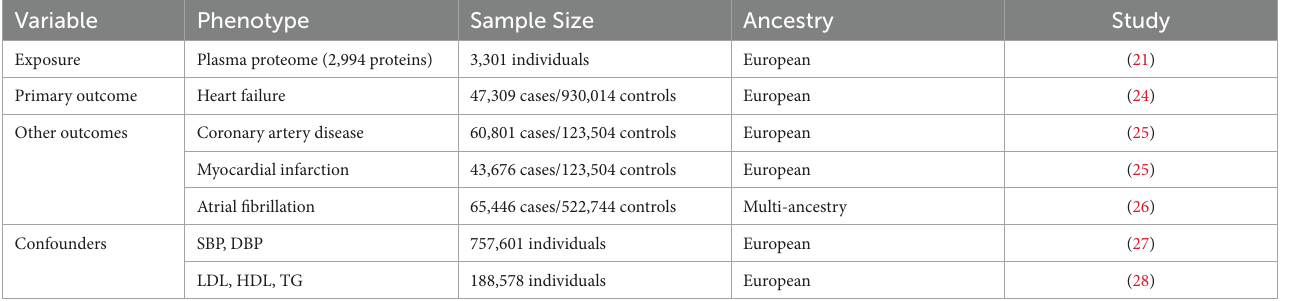
TABLE 1 Descriptive characteristics of the GWASs included in the Mendelian randomization